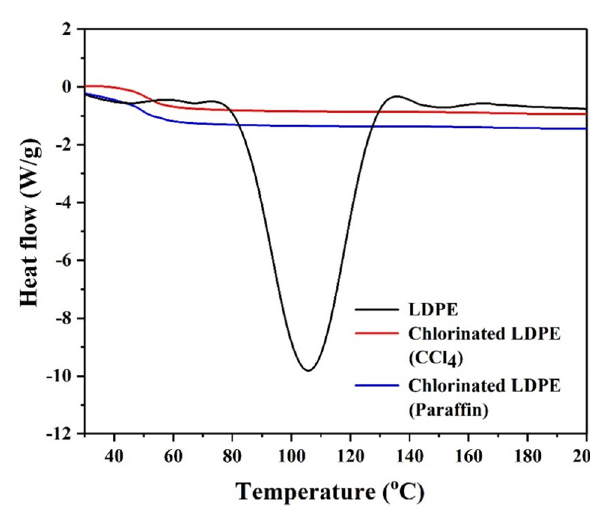
fi rm the degree of crystallinity in LDPE ( before and after chlorination and co - chlorination )